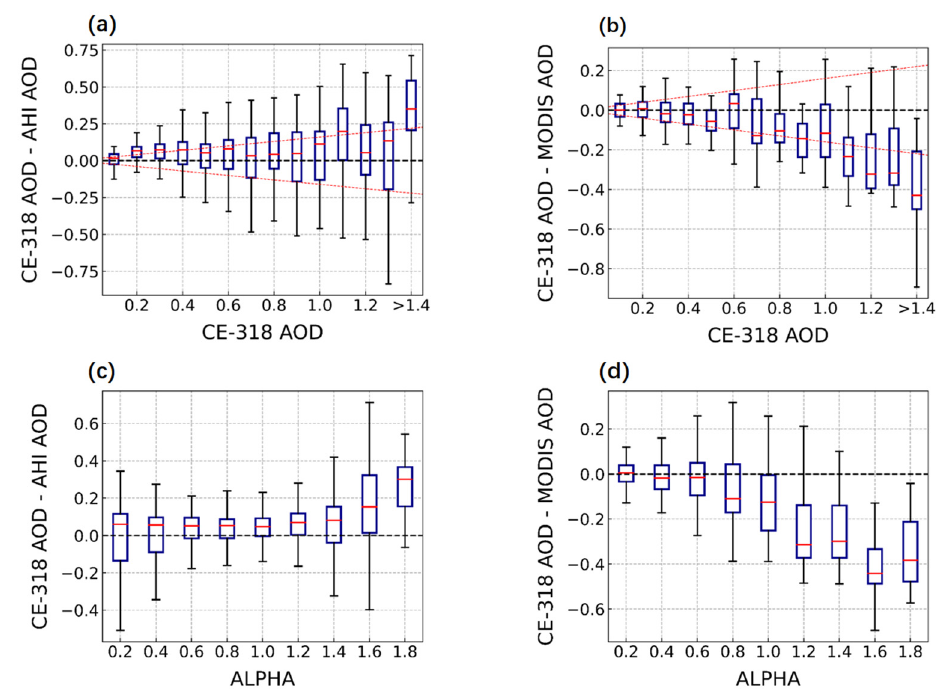
Figure 3. Box plot of the error between AHI and sun photometer AOD with respect to the size of AOD from August 2017 to March 2019 ( a ); the error between MODIS and sun photometer AOD with respect to the size of AOD ( b ); the error between AHI and sun photometer AOD with respect to the Ångström index Alpha ( c ); the error between MODIS and sun photometer AOD with respect to the Ångström index Alpha ( d ). The dark blue boxes represent the upper and lower quartiles, the black line represents the upper and lower edges of the data, and the red horizontal line inside the box represents the data mean. The red dashed line represents the envelope EE of the expected error.